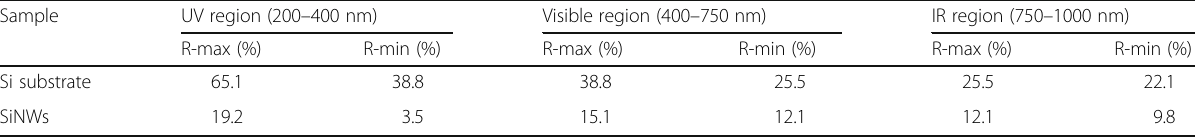
Table 1 Reflectance maximum (R-max) and minimum (R-min) of the Si wafer and SiNWs in the UV, visible, and IR regions Sample